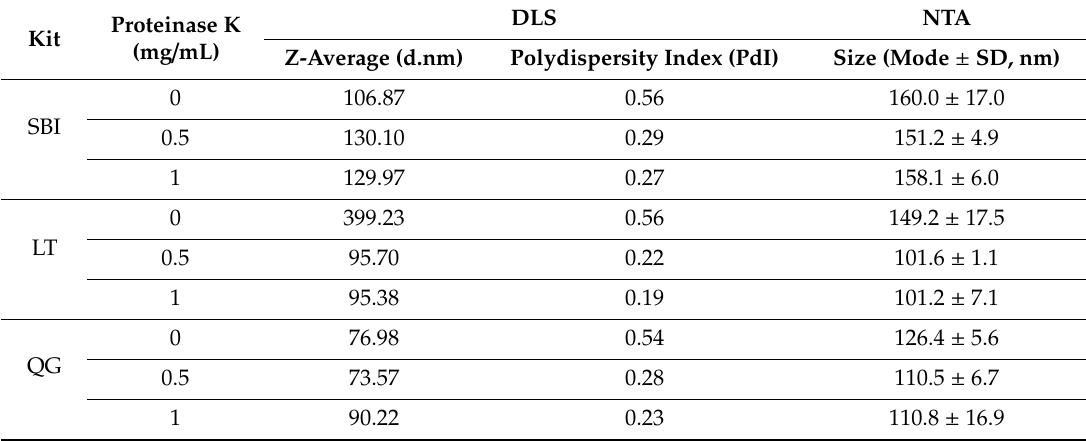
Table 3. Size distribution of ELVs analyzed by nanoparticle tracking analysis (NTA) and dynamic light scattering (DLS)